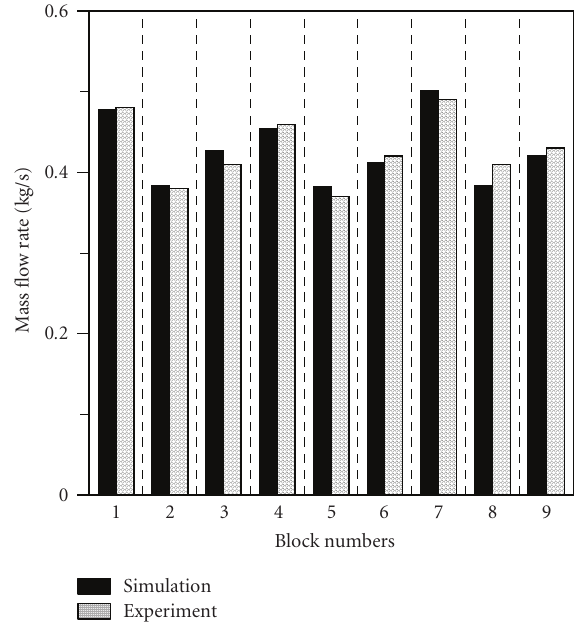
Figure 7: Mass flow rates for the external flow under di ff erent block numbers for the original